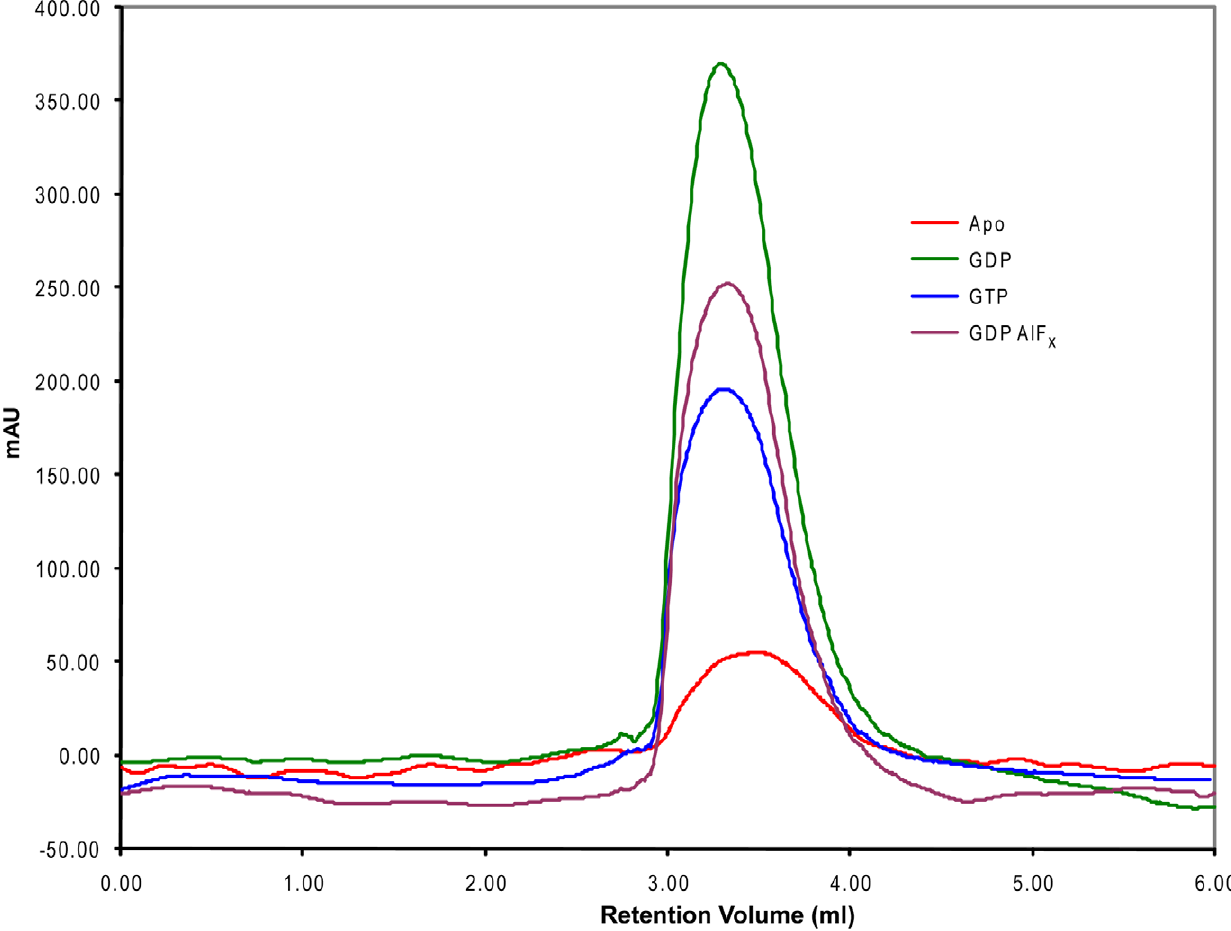
Figure 3. Probing oligomerisation of YqeH in the presence of nucleotides. Analytical gel filtration experiments were conducted in the apo (red curve) and in presence of GDP (green curve), GTP (blue curve) and GDP ? AlF x (pink curve) bound states of YqeH. Absorbance at 280 nm is shown in milli absorbance unit (mAU). The elution profile of YqeH in nucleotide-free apo state (red curve) indicates that it is a monomer. This profile remains unaltered in the different nucleotide bound states.